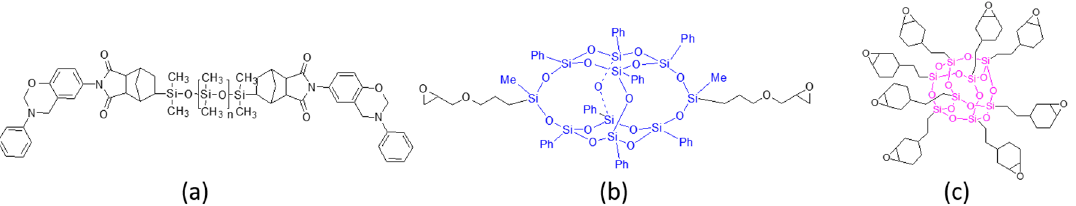
Figure 1. Chemical structure of ( a ) siloxane-imide-containing benzoxazine monomer (SiBZ), ( b ) double-decker silsesquioxane (DDSQ) epoxy, and ( c ) polyhedral oligomeric silsesquioxane (POSS) epoxy.